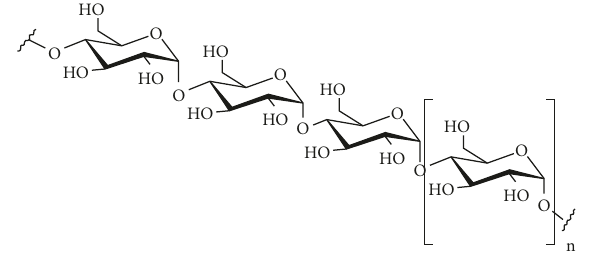
Figure 1: Amylose polysaccharide (chain structure).